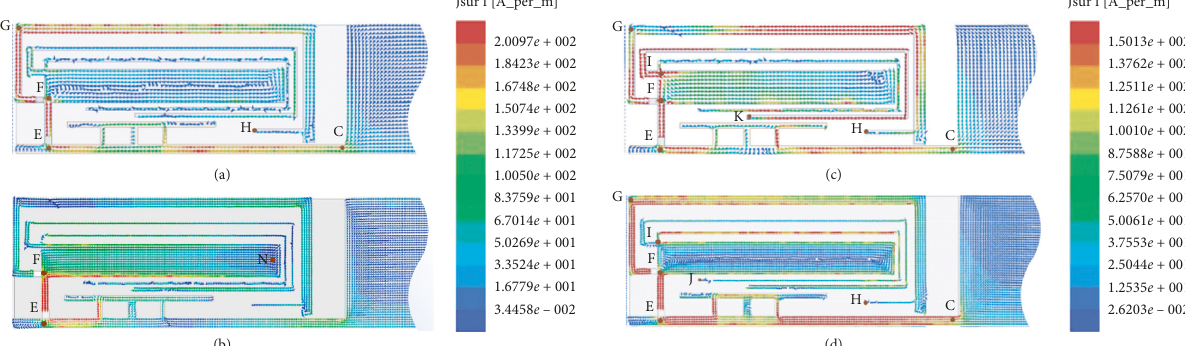
Figure 7: Simulated current distributions on metallic radiators of the proposed antenna at (a) 740MHz, (b) 2300MHz, (c) 2730MHz, and (d)